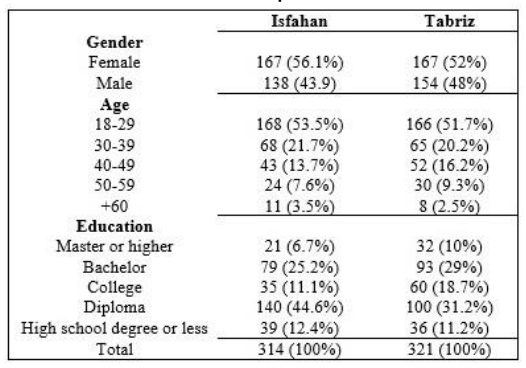
Table 1: Sample Profile